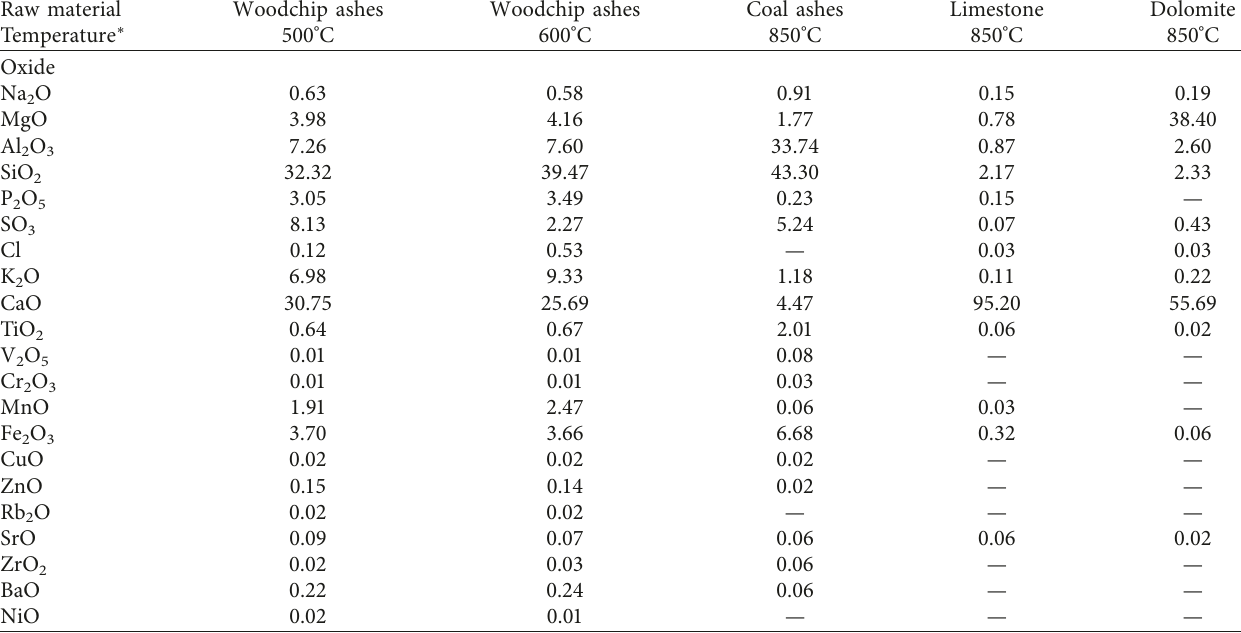
Table 3: The composition of power and desulphurisation component ashes, wt. %.